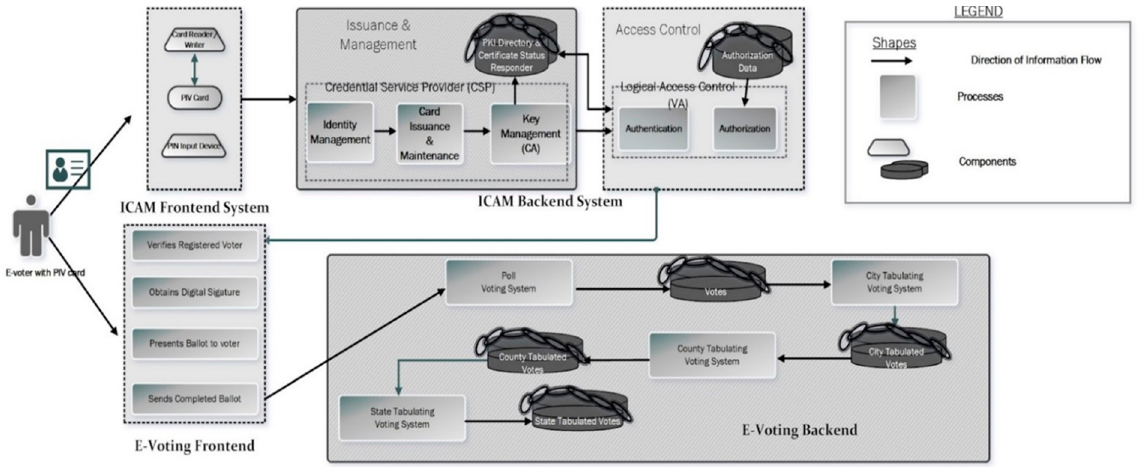
Figure 1. BPES integrated with the ICAM system.